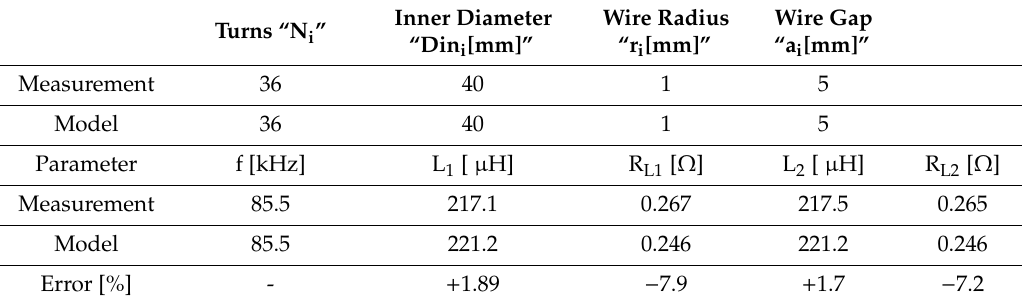
Table 2. Geometry parameters of Non-Shielded Coils for model verification.